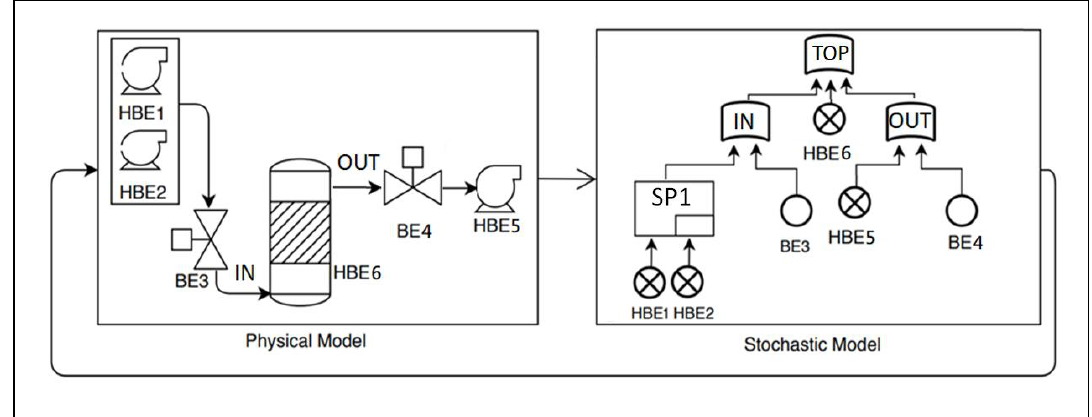
Figure 2. Representation of the Stochastic Hybrid Fault Tree Automaton (SHyFTA) model of the distillation column case study.